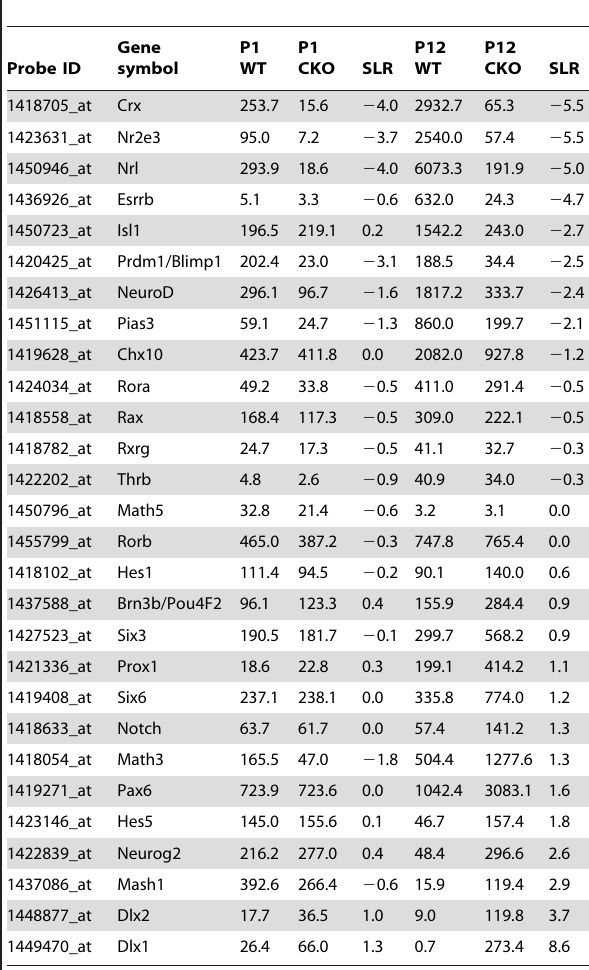
Table 3. Expression of transcription factors involved in retinal development in the Otx2 CKO